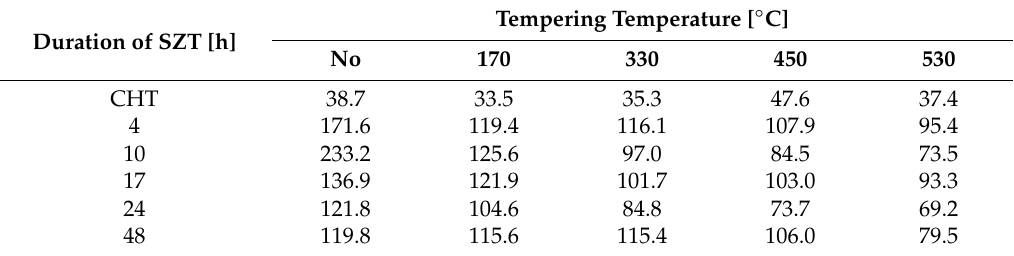
Figure 2. SEM micrographs showing the microstructure of no-tempered steel after conventional heat treatment ( a ), and after SZT at − 75 °C for 4 h ( b ), 10 h ( c ), 17 h ( d ), 24 h ( e ), and for 48 h ( f ). Table 2. Determined values of population density of small globular carbides for di ff erently sub-zero treated and tempered